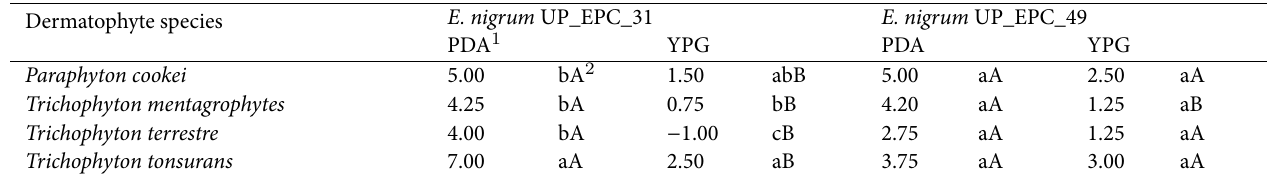
Table 2 The individual biotic effect (IBE) between the strains of Epicoccum nigrum and dermatophytes after 10 days of combined growth on PDA and YPG media plates. The same experiment was performed in four independent replicates. Dermatophyte